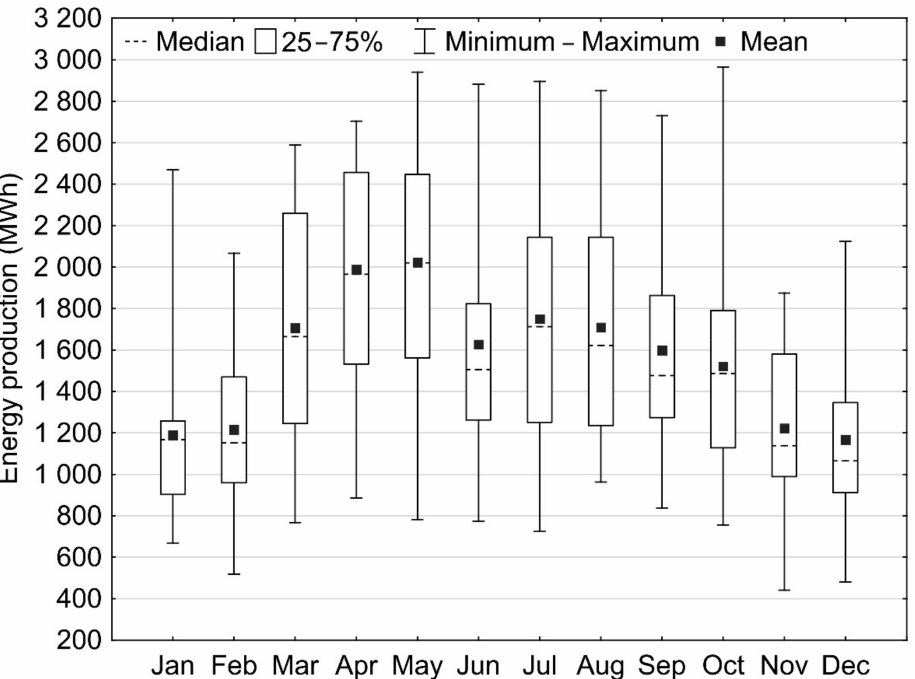
Figure 2. Monthly changes in energy production by the Jeziorsko hydropower